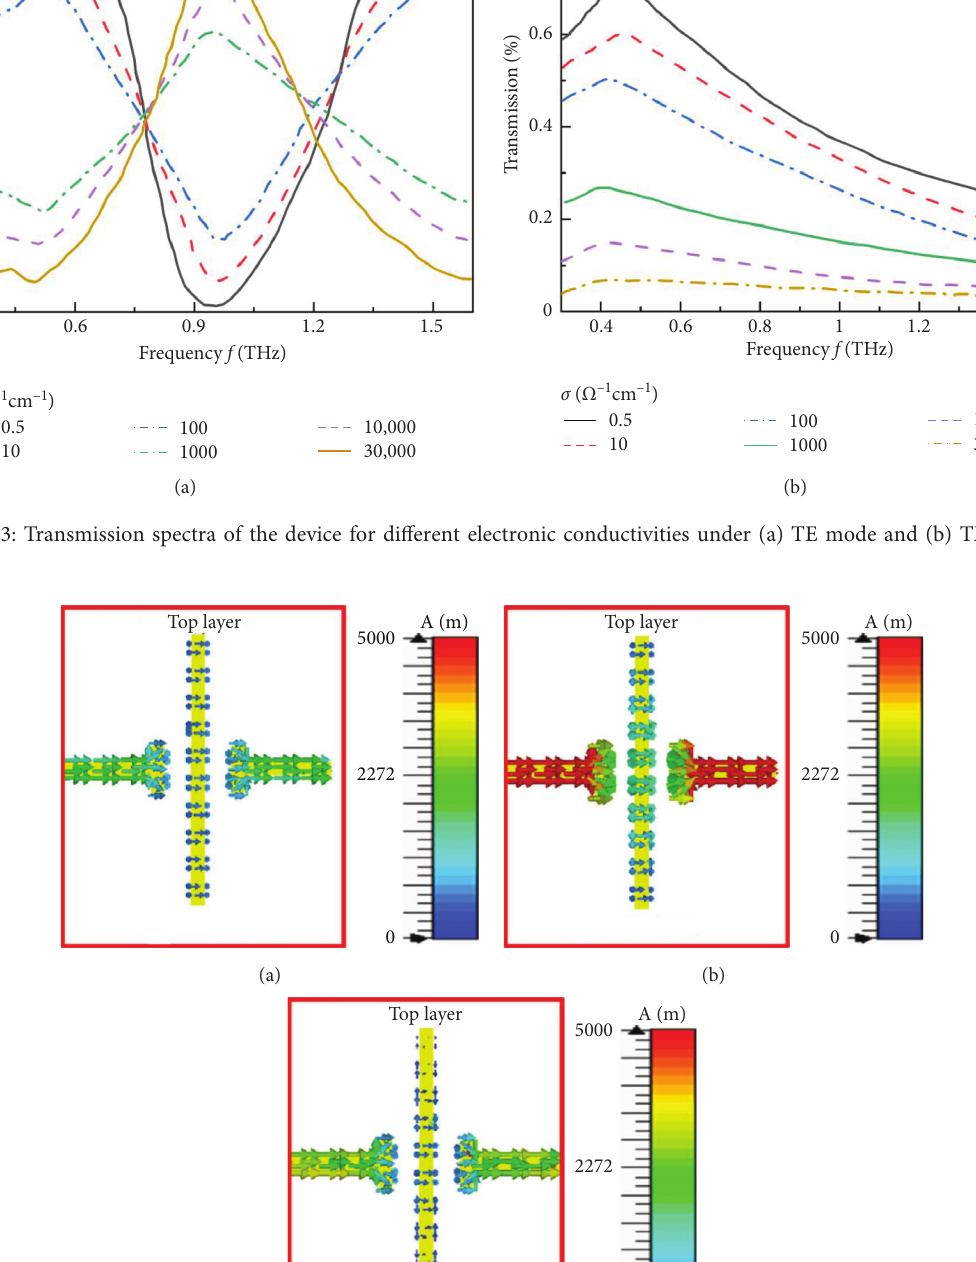
2 is in the insulating state for the frequencies of (a) 0.6THz, (b) 0.95THz, and